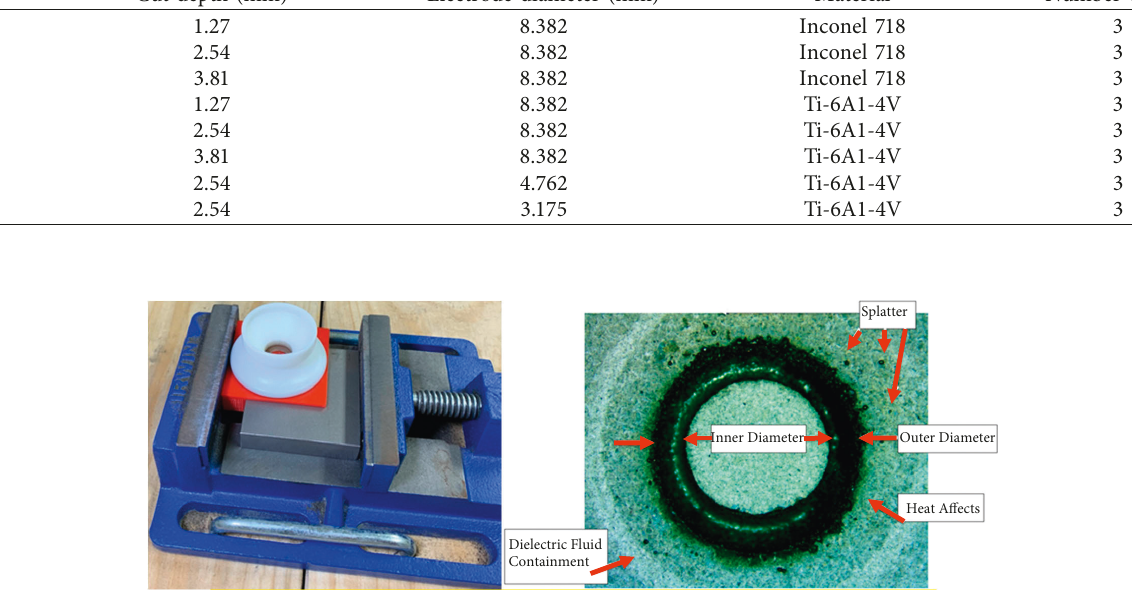
Figure 3: Testing arrangement (a) and cut made during electrode wear study (b).